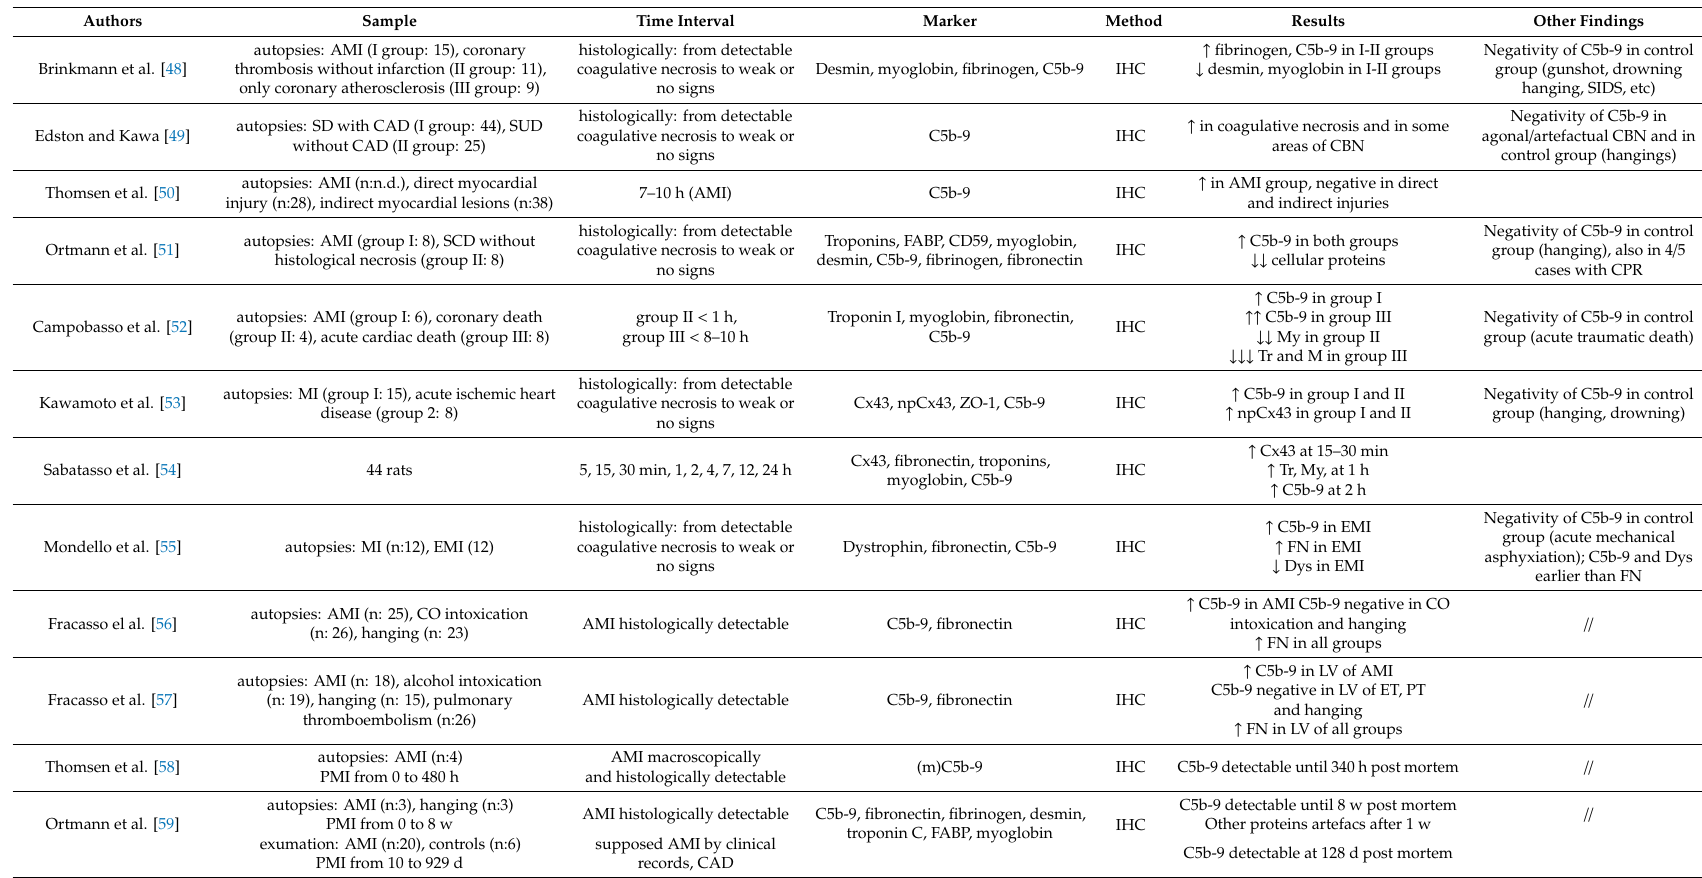
Table 2. Summary of the main data resulting from the analyzed forensic